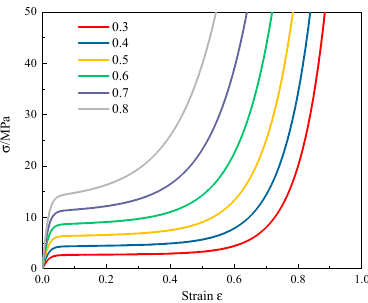
Figure 9. The stress–strain curve of the aluminum honeycomb matrix.